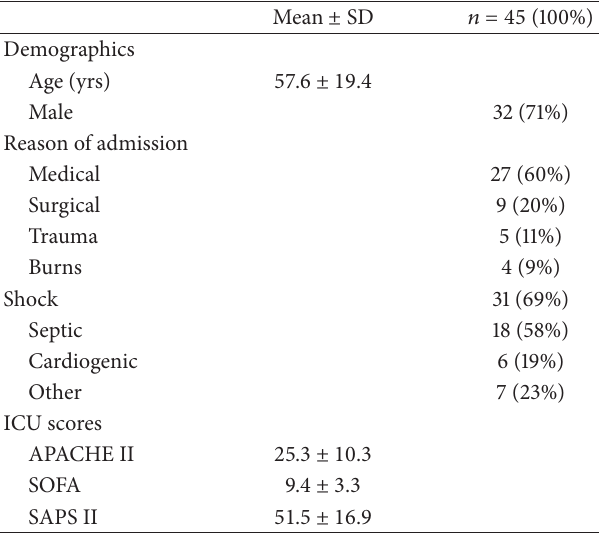
Table 1: Patient